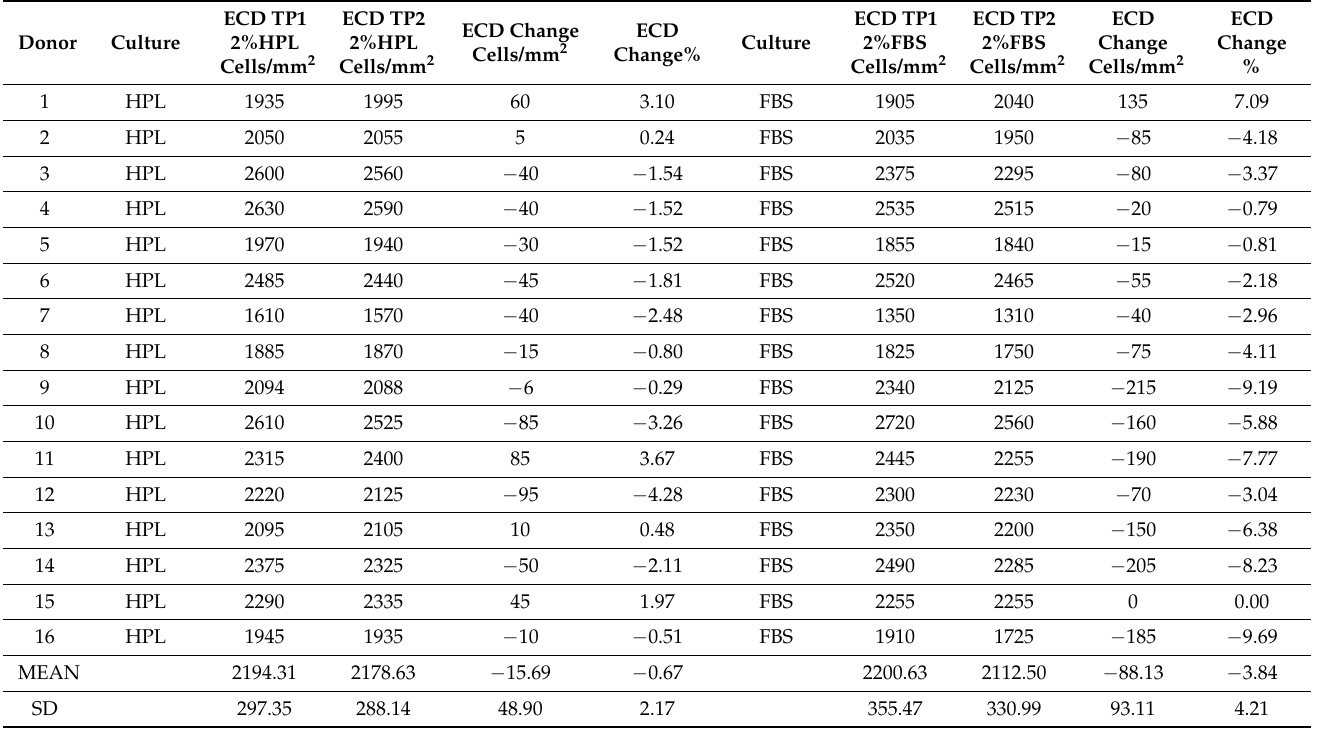
Table 2. Changes in endothelial cell density (ECD) of paired donor corneas at TP1 (after 3 days of